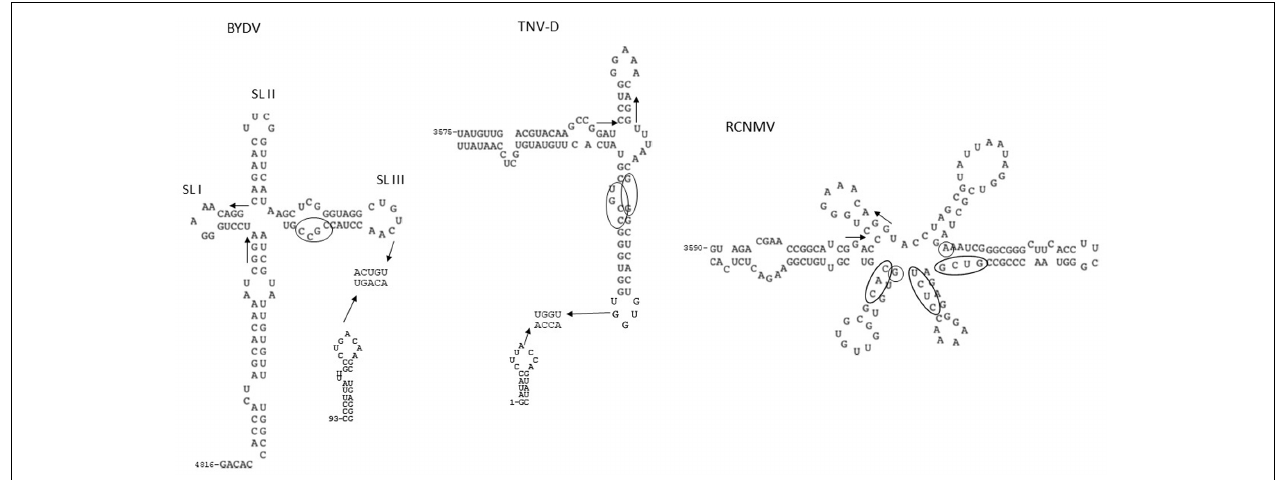
FIGURE 1 | RNA secondary structures of BTEs, which are 3 (cid:48) -CITEs that interact with eIF4F through its eIF4G subunit. Assayed RNA secondary structures of representative BTEs of BYDV, TNV-D, and RCNMV, based on data derived from Wang et al. (2010). The conserved BTE-specific 17 nt are indicted with arrows (start/end). Bases protected by eIF4G, apart from the 17 nt stretch, are encircled (Kraft et al., 2013). Sequences proved or proposed to be involved in 5 (cid:48) –3 (cid:48) interaction through sequence complementarity are shown for BYDV and TNV-D BTEs.